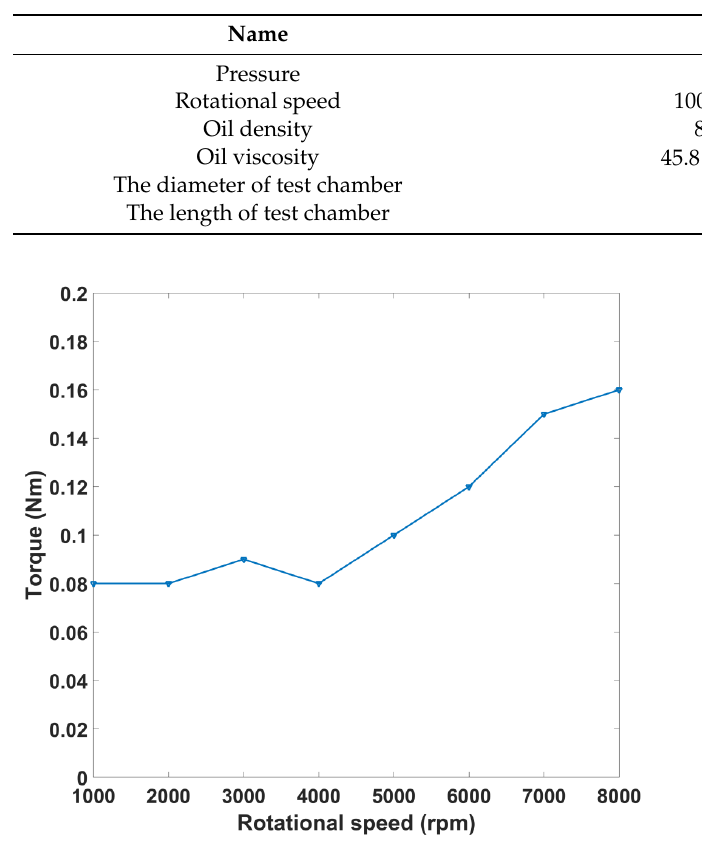
Table 2. The experimental conditions.